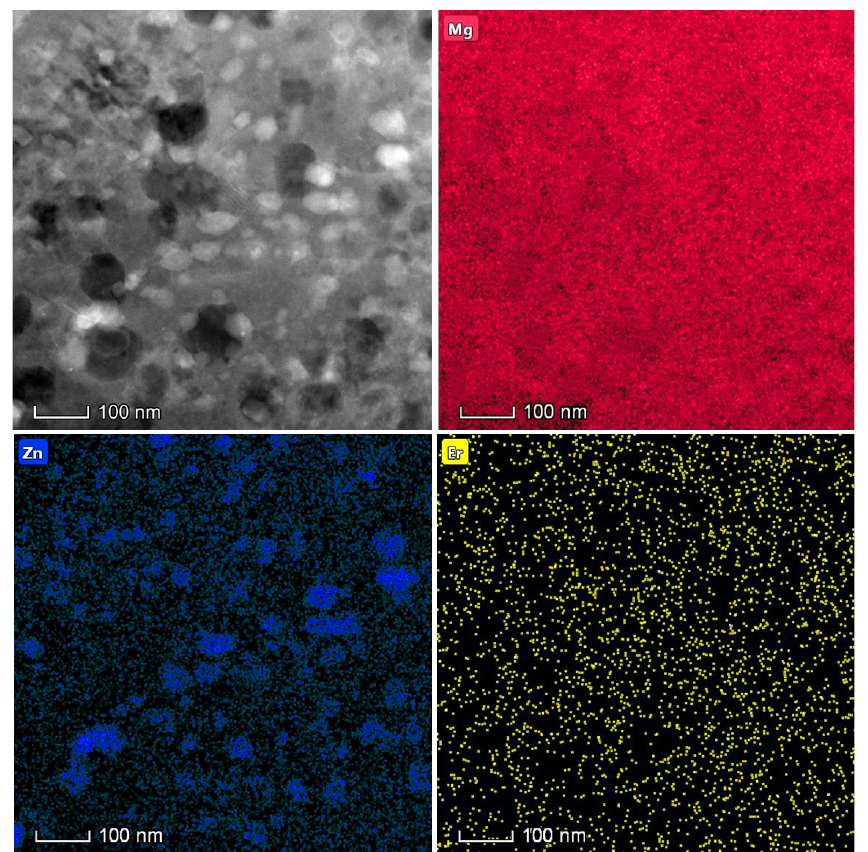
Figure 6. Mappings of nano-MgZn 2 phases in cryogenic MD-rolled alloy after 100 °C compression. Metals 2022 , 12 , 2114